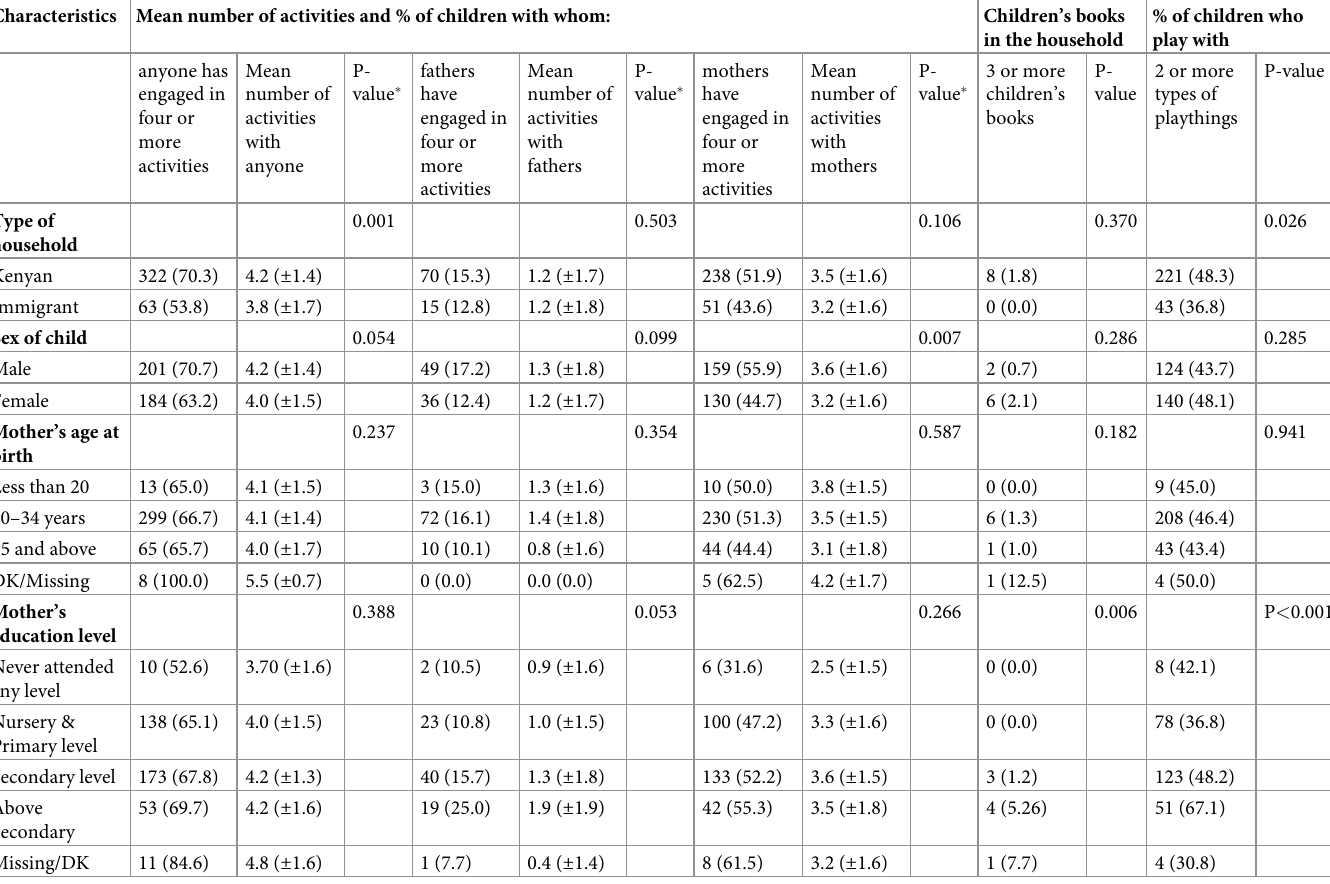
Types of play things are in form of: Homemade toys, toys from a shop/manufactured toys and household objects/objects found outside. ± : Standard deviation; P-value � : P-value for Chi-square test of differences in engagement in 4 or more activities; P-values for continuous variables are a product of T-test or ANOVA and for binary/ categorical variables are from Chi-square or Fisher’s exact test